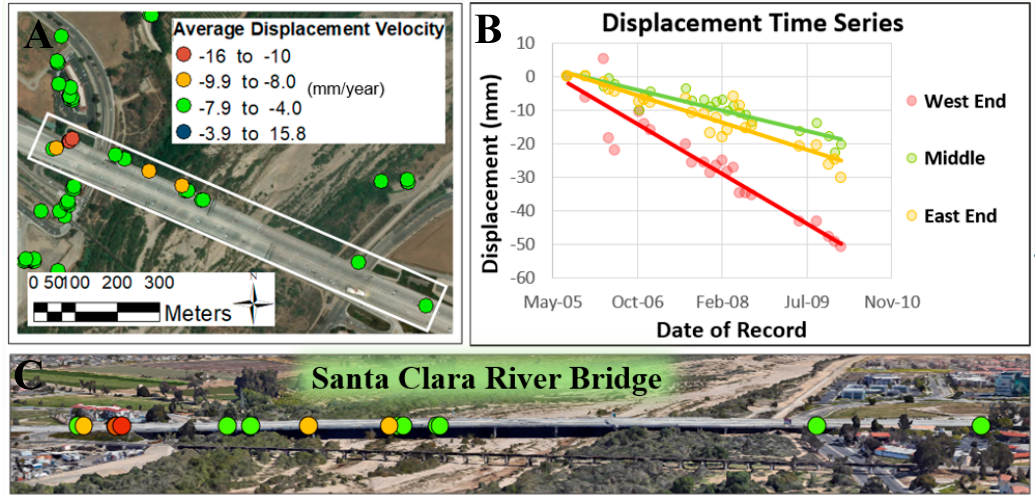
Figure 4. Santa Clara River bridge displacement model. ( A ) Aerial view of the bridge; ( B ) Displacement time series; ( C ) Elevation view of the bridge. Source: Images for Figure 4A,C were obtained from Google Earth [48].